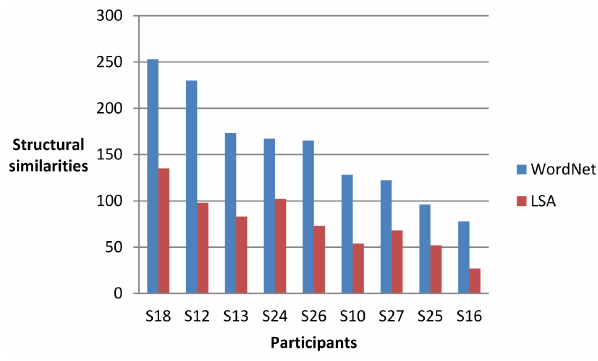
Figure 17. Significant structural similarities (partial orders of similarity differences invariant between the brain data and the linguistic data) for the set of words { Paris,Vienna,Athens,north, south, east, west, Italy, Spain, Austria } from 60 single-trial classifications for each participant.